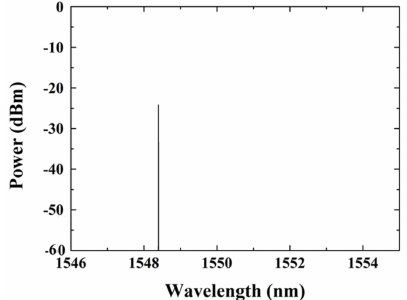
Figure 10. The spectrum of λ 2 at the drop port 2 with the drop process.